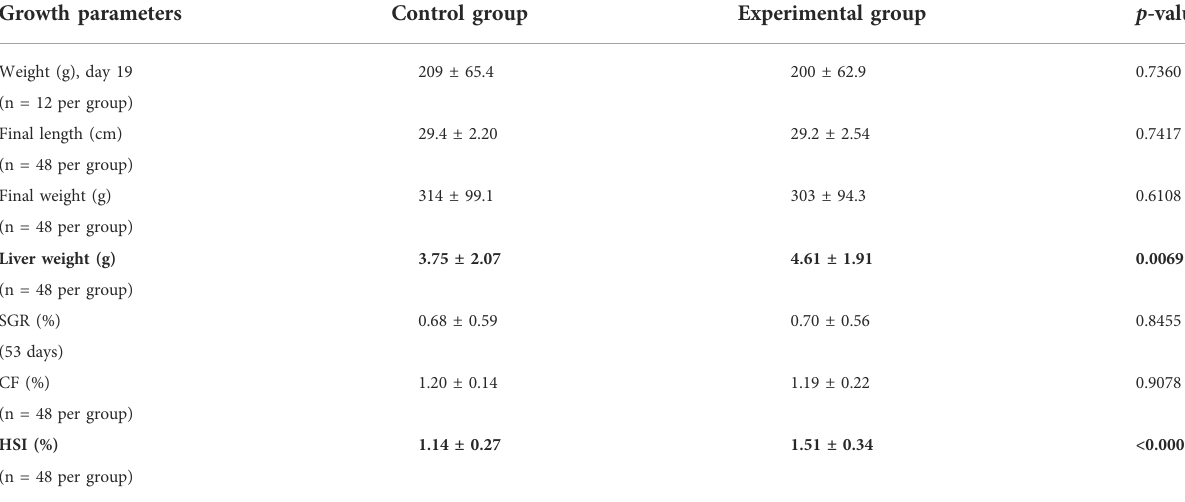
TABLE 4 Growth parameters for fi sh fed with control feed or experimental yeast-based feed. Data are presented as the mean ± standard deviation. Statistical signi fi cance was set at p -value < 0.05. Growth parameters